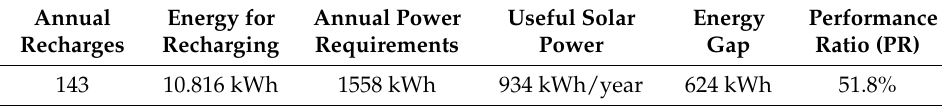
Table 3. Summary of the results of the simulation obtained with PVSYS.